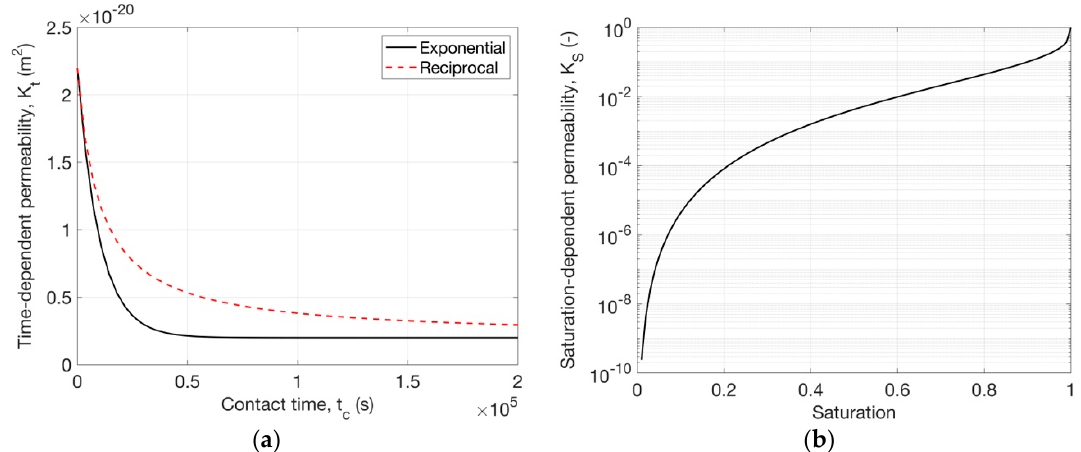
Figure 5 . An example of kinetic permeability: ( a ) time-dependent permeability as a function of contact time for a drying process (with K 1 = 0.2 × 10 − 20 m 2 , K 1 = 2 × 10 − 20 m 2 , a = 1 and τ = 10000 s); ( b ) saturation-dependent permeability for the studied material.